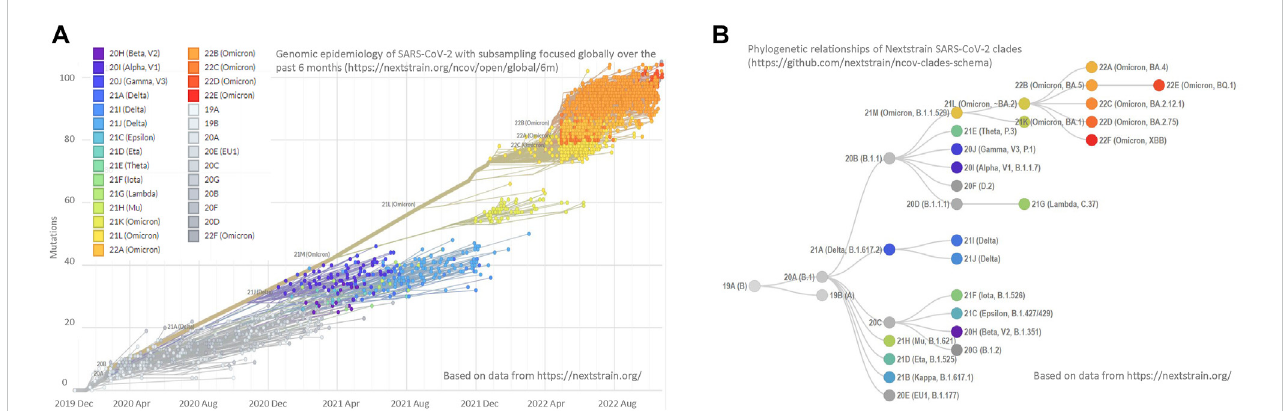
FIGURE 1 Distribution and phylogeny of SARS-Cov-2 variants (A) Data from GenBank has been used to visualize the genomic epidemiology of SARS-CoV- 2globally over thepast 6 months.The graph shows mutations of2,853 genomes sampledbetweenDecember 2019 andOctober2022 andis constructed by Nextstrain. (B) The chart visualizes the phylogenetic tree of SARS-CoV-2 variants. The phylogeny tree is enabled by Nextstrain (Had fi eld et al.,